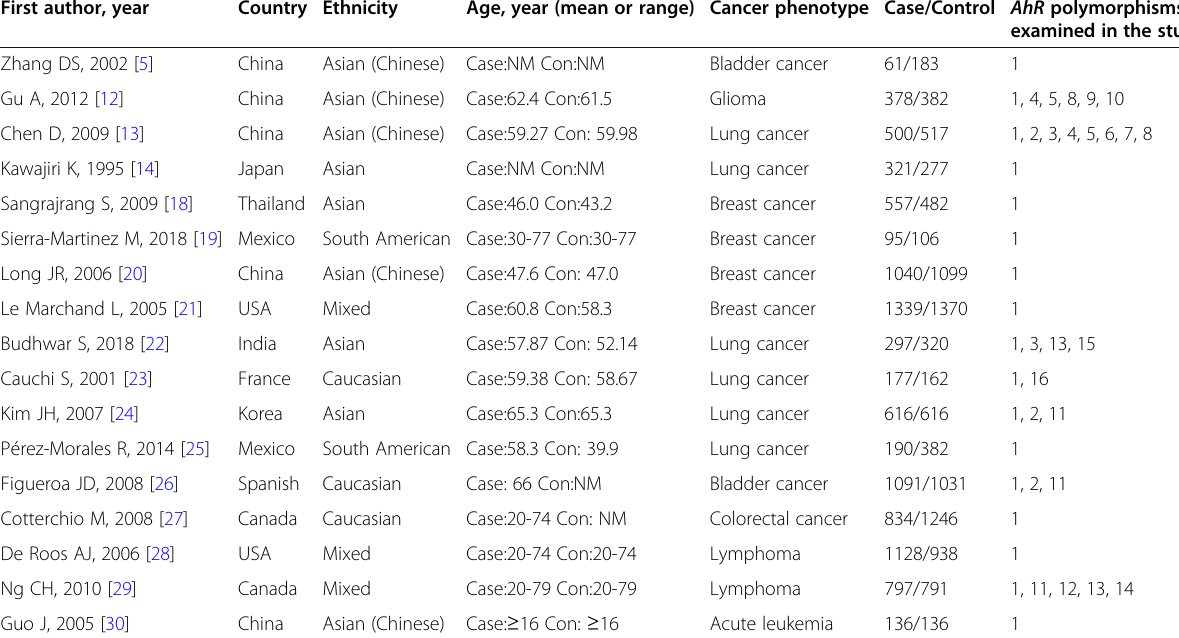
Table 1 Characteristics of studies included in this